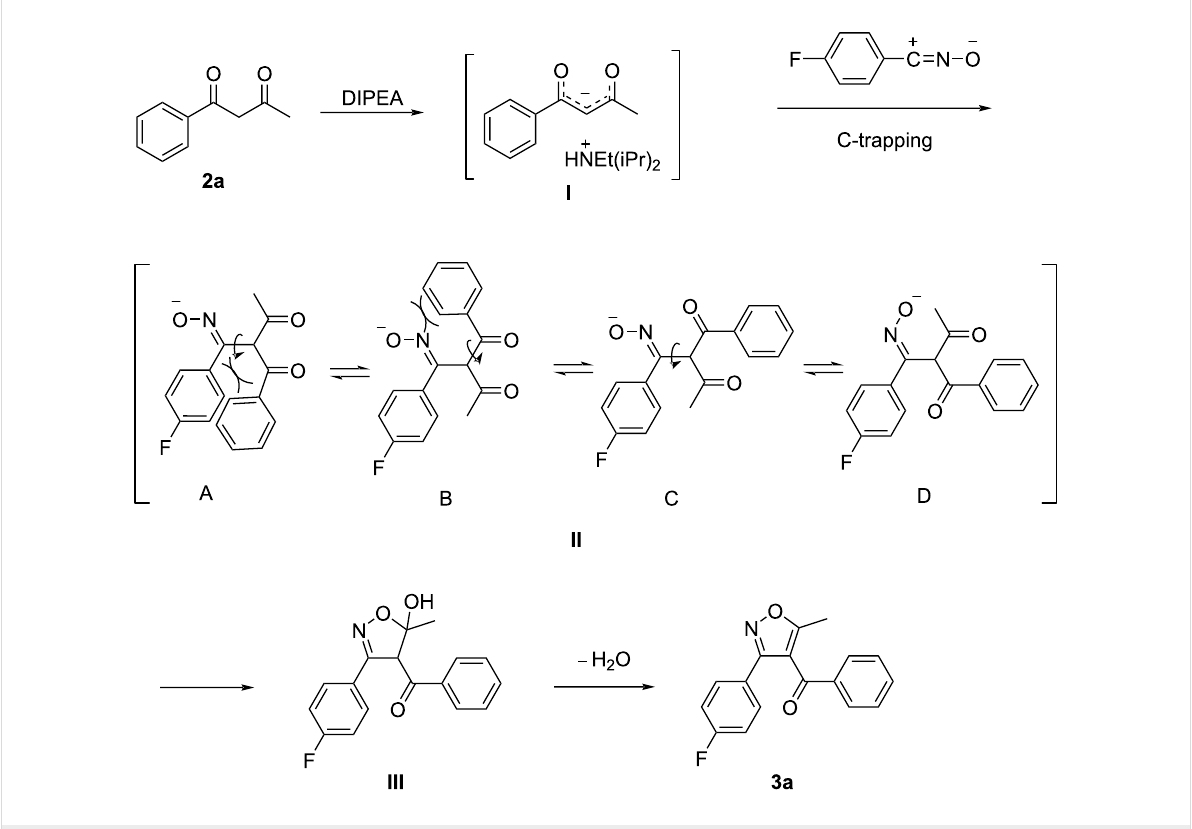
Figure 8: A plausible mechanism for the formation of the 3,4,5-trisubstituted isoxazoles 3 in the presence of DIPEA in polar solvents like water or